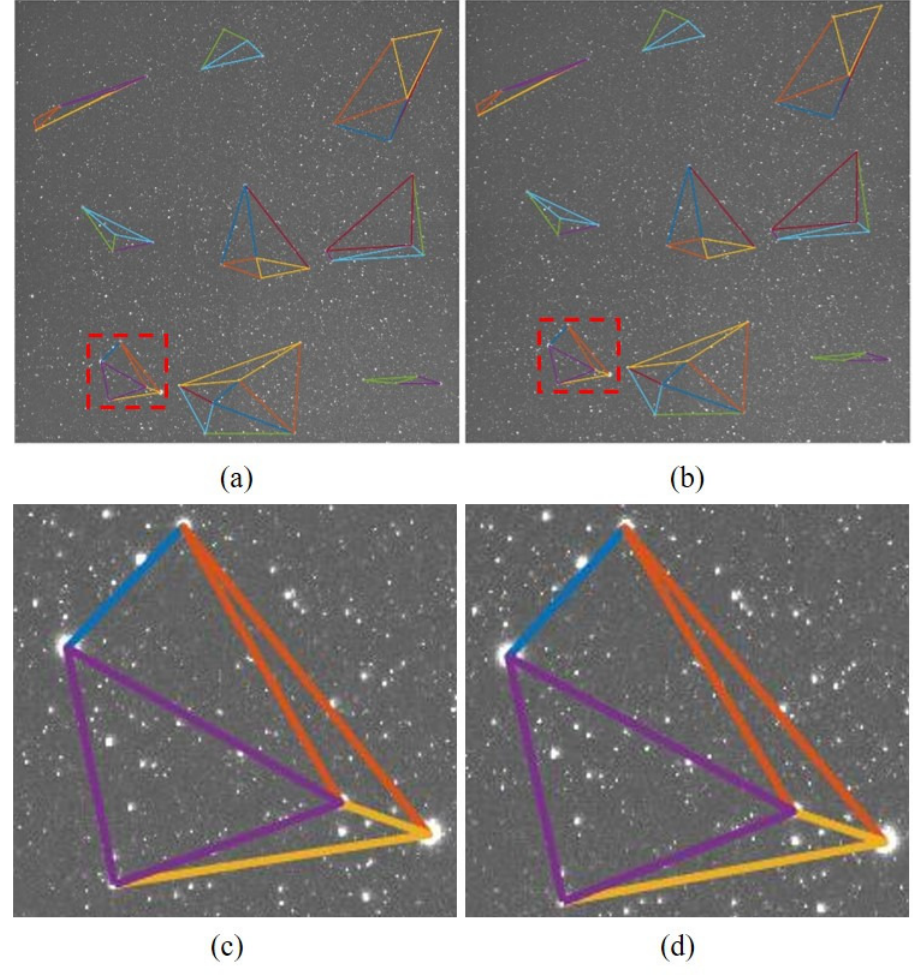
Figure 2. An illustration of triangle construction in two images for registration. ( a ) Reference image. ( b ) Current image. ( c ) Photomicrographs of the marked region in ( a ). ( d ) Photomicrographs of the marked region in ( b ).